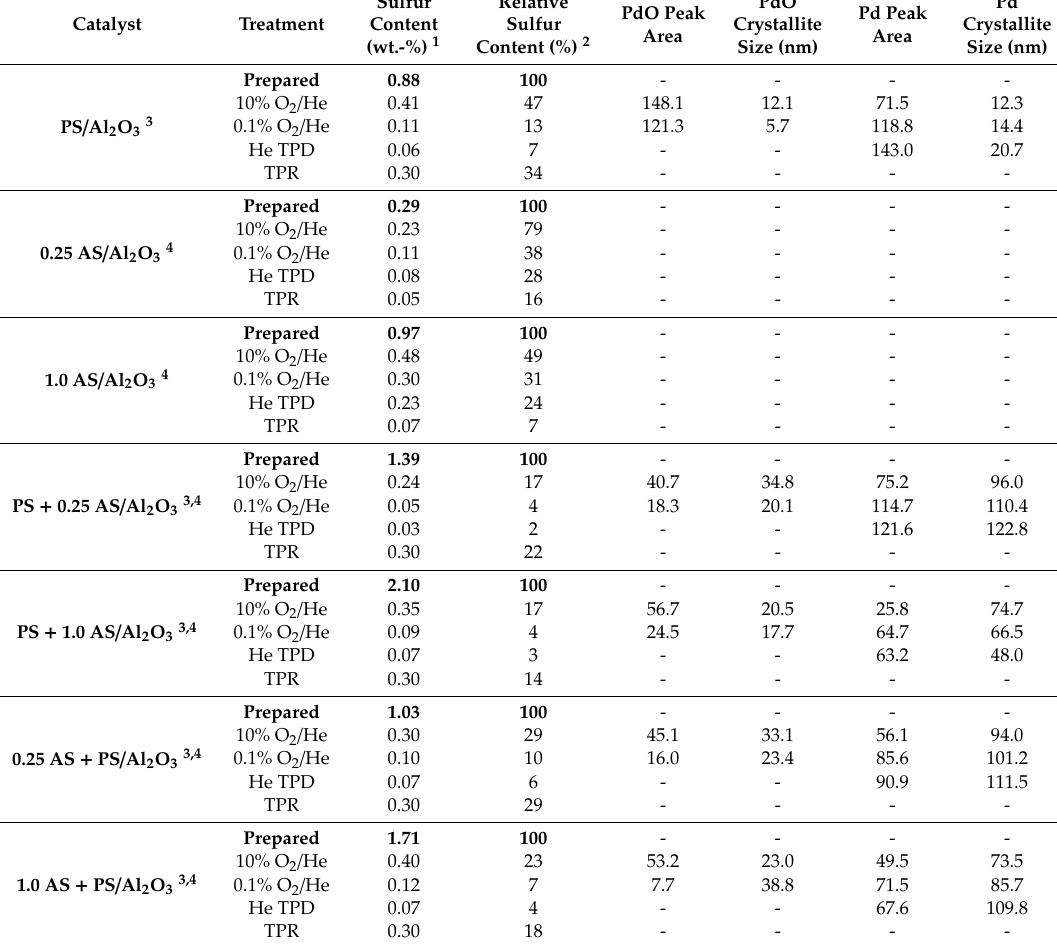
Table 1. Designation of the catalysts, sulfur contents, and PdO and Pd peak areas and crystallite sizes.